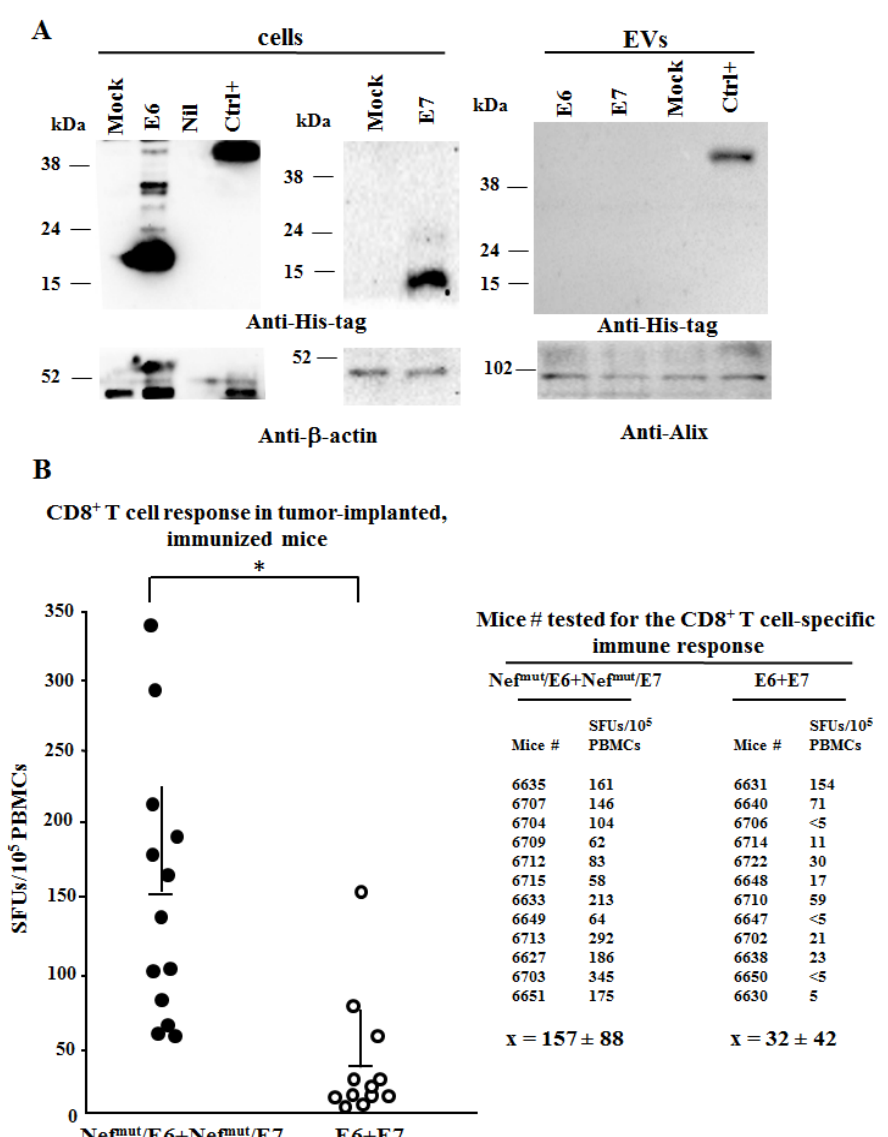
Figure 4. HPV16 E6- and E7-specific CD8 + T cell immunity induced in tumor-implanted mice. ( A ) Analysis of both HPV16-E6 and -E7 products in HEK293T transfected cells and respective EVs. Western blot analysis of 30 µ g of lysates from cells transfected with DNA vectors expressing the indicated HPV16 ORFs (left panels), and equal volumes of buffer where purified EVs were resuspended after differential centrifugations of the respective supernatants (right panels). As control, conditions from mock-transfected cells as well as cells transfected with Nef mut fused with a scFv (Nef mut /GO, Ctrl+) expressing a His-tag at its C-terminus were included. Polyclonal anti-His-tag Abs served to detect both HPV16-related and Nef mut /GO products, while β -actin and Alix were revealed as markers for cell lysates and EVs, respectively. Molecular markers are given in kDa. The results are representative of two independent experiments. ( B ) CD8 + T cell immune response in C57 Bl/6 mice implanted s.c. with 2 × 10 5 TC-1 cells, and then inoculated+EP with 10 µ g of DNA vectors expressing E6 and E7 either alone or fused with Nef mut . PBMCs were isolated after retro orbital bleeding, and then incubated o.n. with or without 5 µ g/mL of either unrelated or E6+E7-specific nonamers in triplicate IFN- γ EliSpot microwells. Shown are the number of IFN- γ SFUs/10 5 PBMCs as mean values of triplicates after subtraction of values from wells treated with unrelated peptides. On the right, the SFU values are associated with each mouse. Intragroup mean values + SD are also reported. * indicates statistically significant differences.